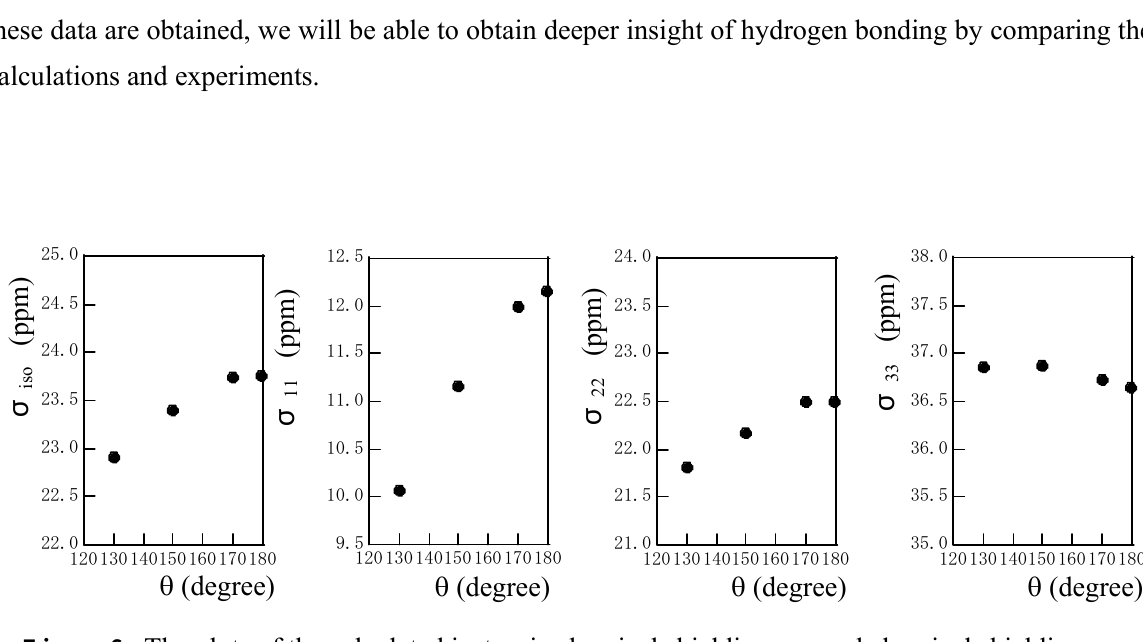
Figure 6. The plots of the calculated isotropic chemical shielding σ tensor components σ , σ and σ of the amide proton of an N-methylacetamide hydrogen- 11 22 33 bonded with a formamide against the hydrogen-bond angle θ